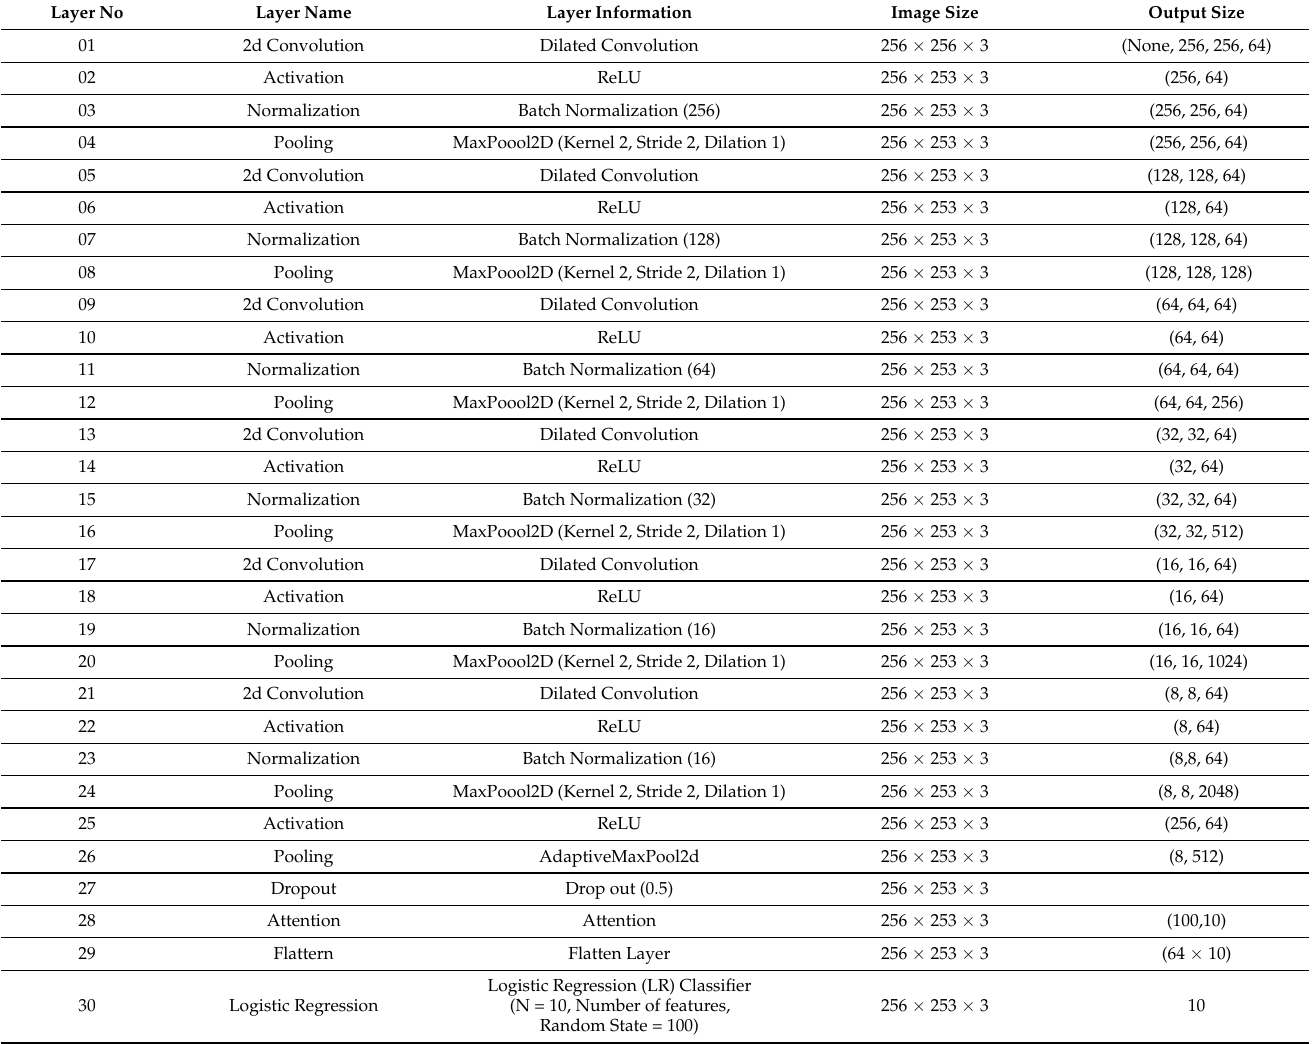
Table 2. Network parameter of the proposed